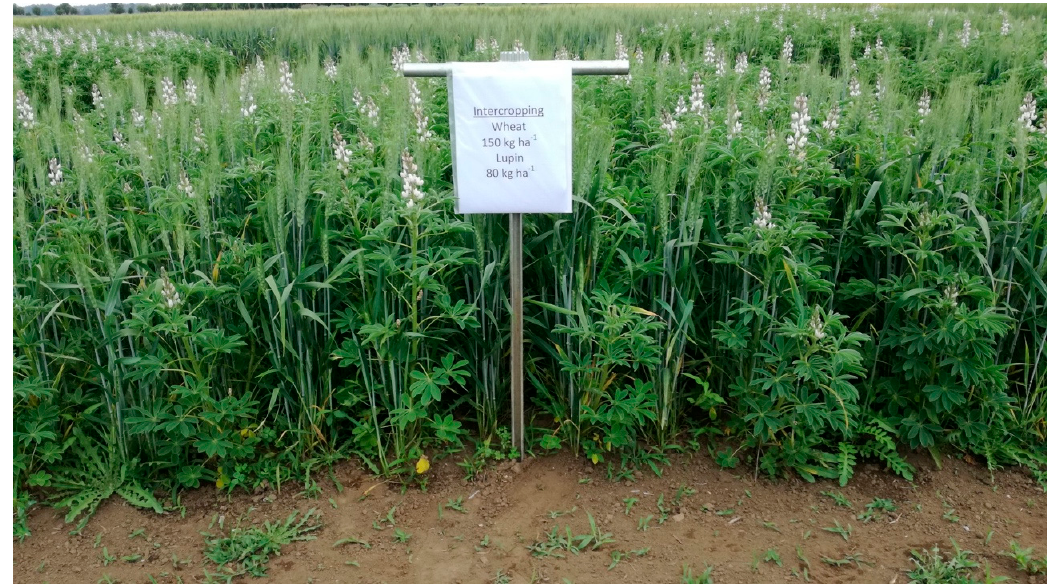
Figure 1. Wheat intercropped with white lupin at low plant densities in an acidic Andisol.